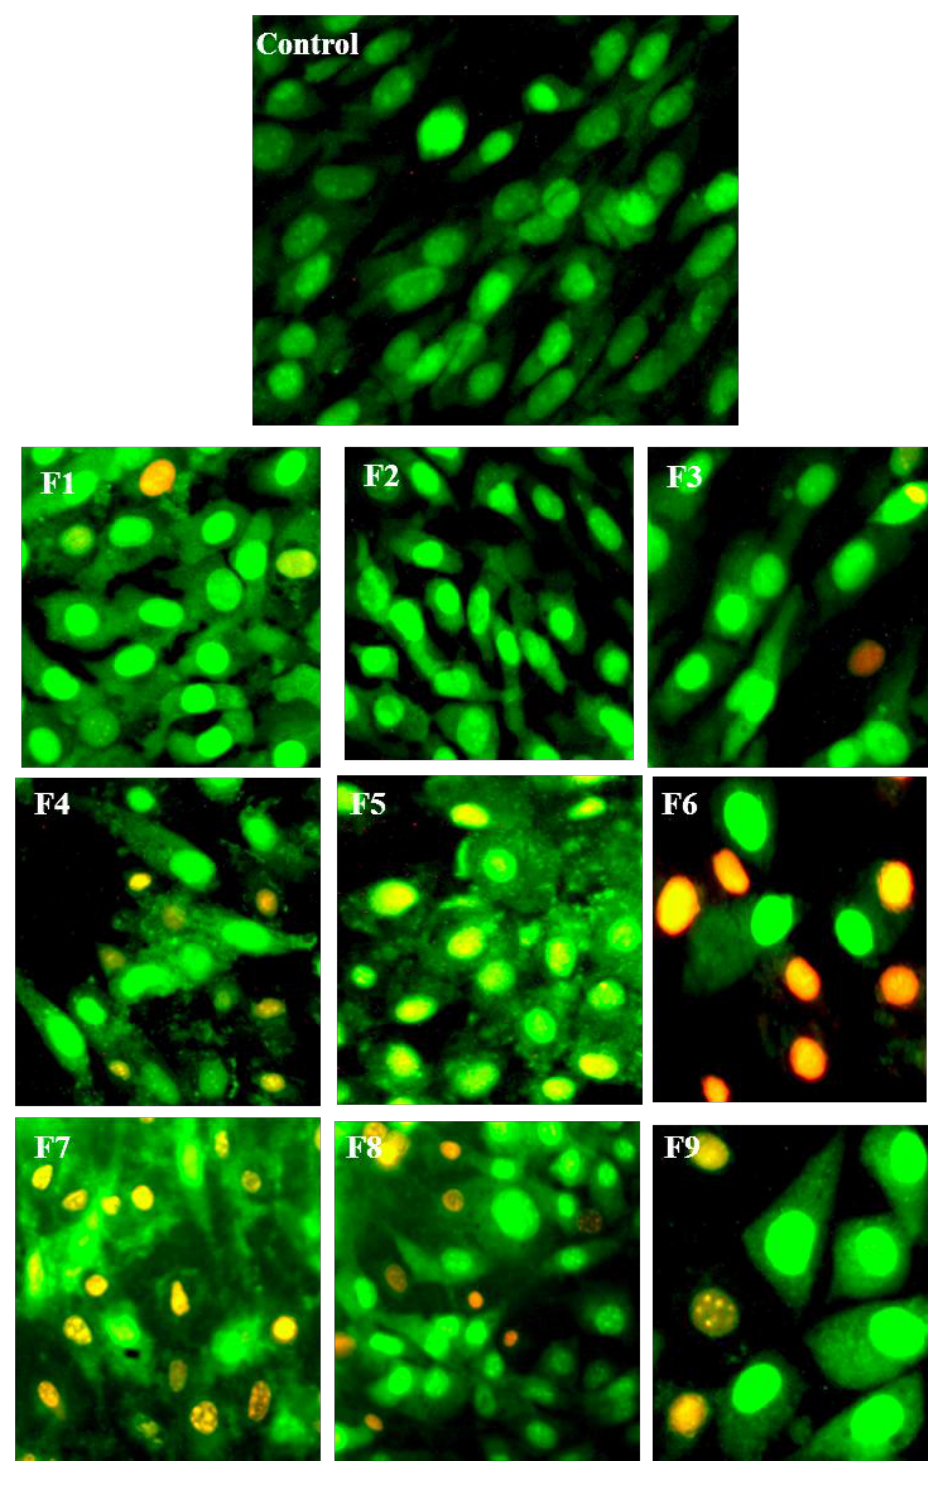
Figure 4. Representative fluorescence microscopic images of cells double-stained with acridine orange (0.3 mg·mL −1 ) and ethidium bromide (1 mg·mL −1 ) after 24 h of exposure to F1–F9. Images of the fields were acquired with a magnification of